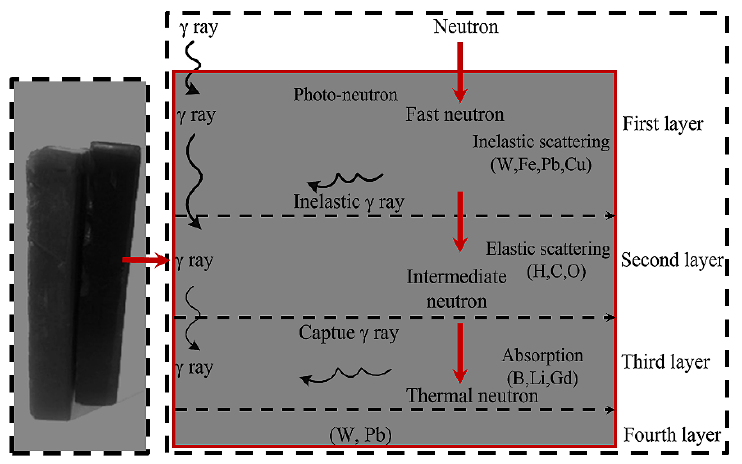
Table 6. Performance comparison of PI-based neutron-shielding materials.